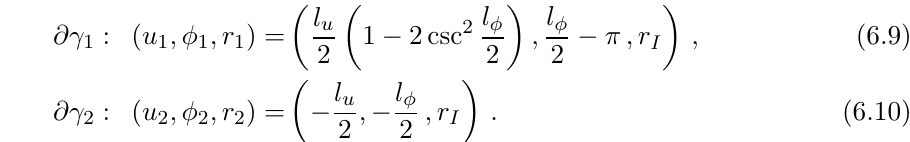
JHEP07(2017)142 = 0. The two t . The union t